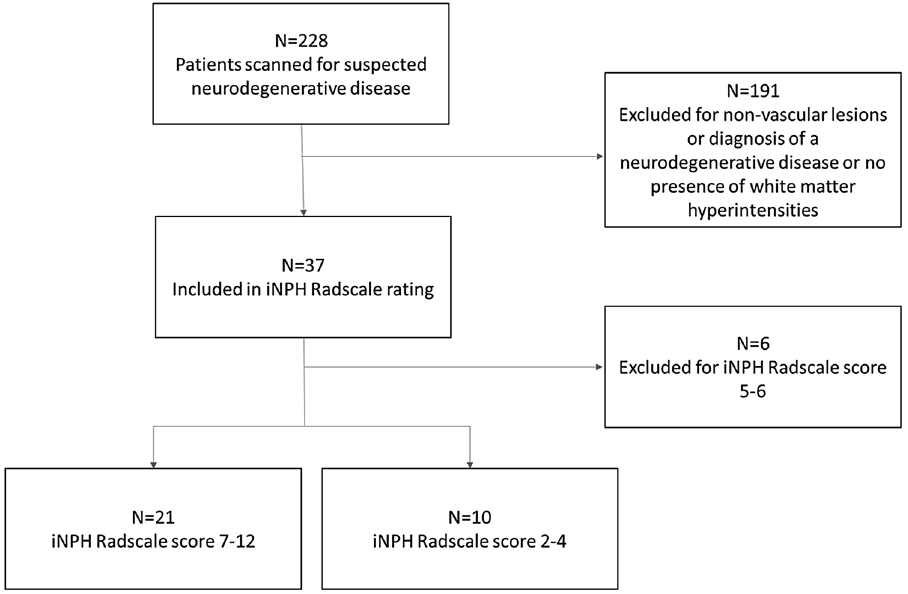
Figure 2. Summary of patient selection and group